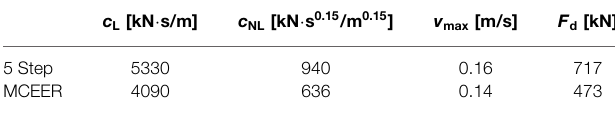
TABLE 1 | Non-linear dampers characteristics along the X direction .